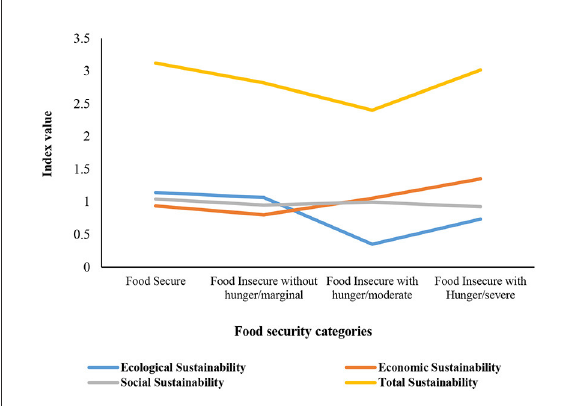
FIGURE4 The status of ecological, economic, and social sustainability in different categories of food security.